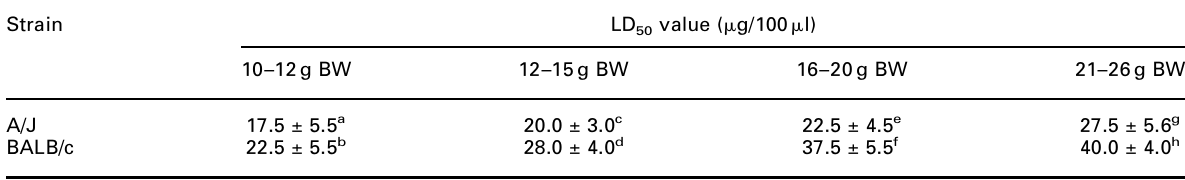
Groups of female mice from A/J and BALB/c strains, with different body weights, were injected i.p. with different amounts of TSV. Deaths occurring during 24h were recorded and the LD 50 value was calculated. a,b Not significant, c,d p < 0.1, e,f p > 0.05, g,h p <